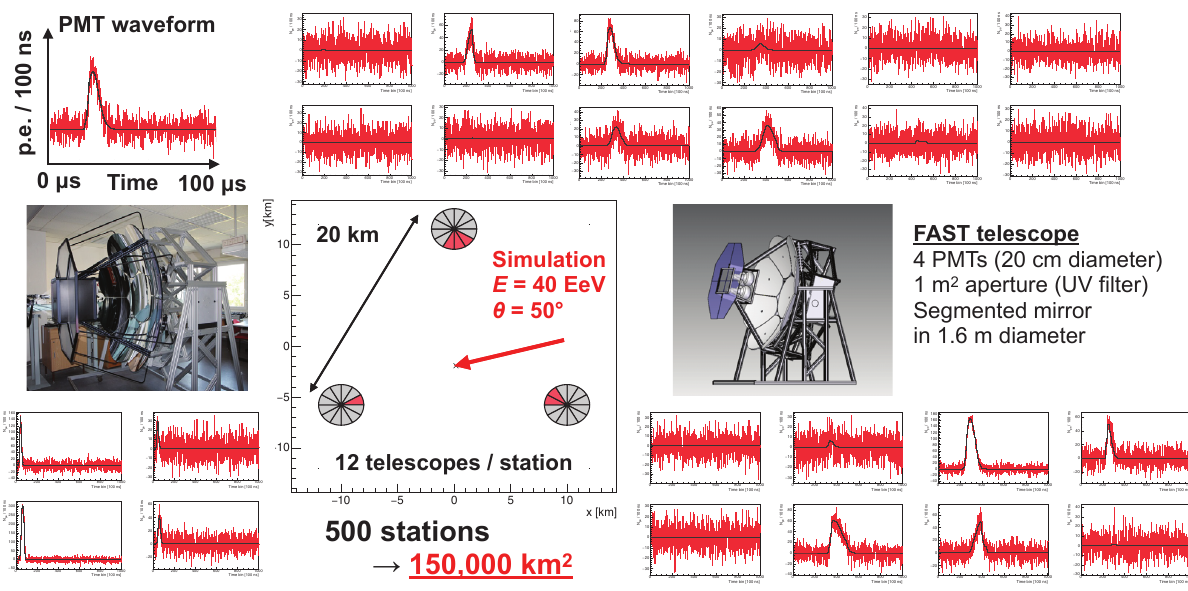
Figure 1. The Fluorescence detector Array of Single-pixel Telescopes: a possible solution for a future giant ground array [6]. The traces show simulated signals emitted from a UHECR with an energy of 40EeV and a zenith of 50 ◦ . The black curves in the waveforms show the simulated traces without contributions of the expected night sky